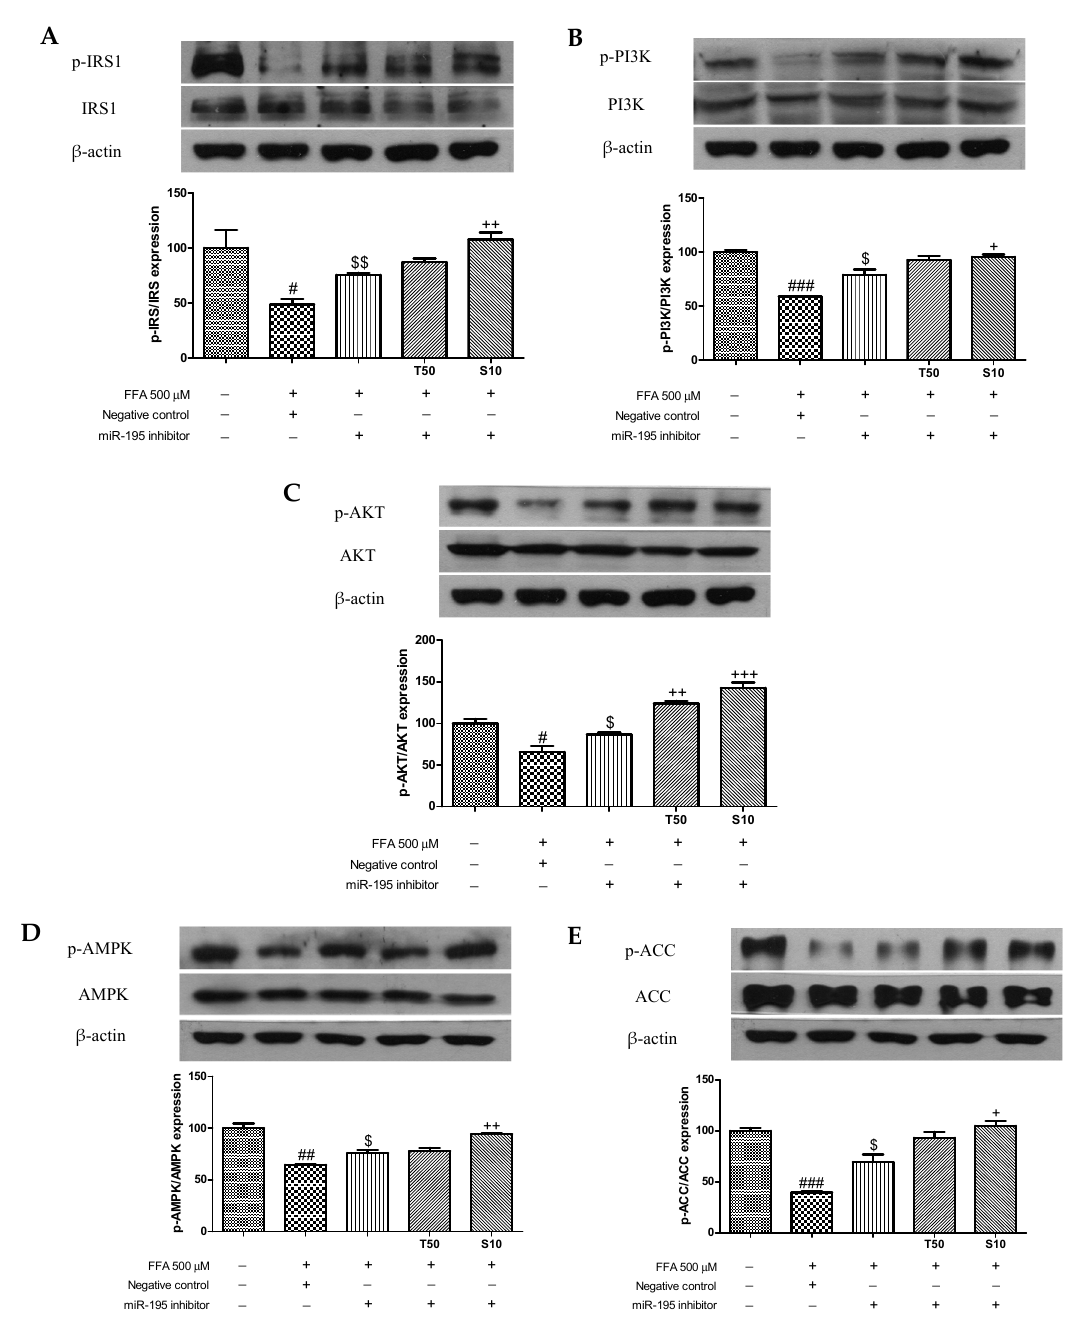
Figure 6. Transfection with the miR-195 inhibitor partially prevents taxifolin- and sorghum ethanol extract-mediated regulation of the IRS1/PI3K/AKT and AMPK signaling pathways in HepG2 cells following the FFA treatment. Relative ( A ) p -IRS1, ( B ) p-PI3K, ( C ) p-AKT, ( D ) p-AMPK, and ( E ) p-ACC protein levels in HepG2 cells transfected with the miR-195 inhibitor (50 nM) or its negative control (50 nM). Data are presented as the mean ± standard error (n = 3). # p < 0.05, ## p < 0.01, and ### p < 0.001 versus the control cells; $ p < 0.05, and $$ p < 0.005 versus the FFA+negative control-treated cells; + p < 0.05, ++ p < 0.01, and +++ p < 0.001 versus the miR-195 inhibitor-treated cells. FFA, free fatty acid; T, taxifolin ( μ M); S, sorghum ethanol extract ( μ g/mL).